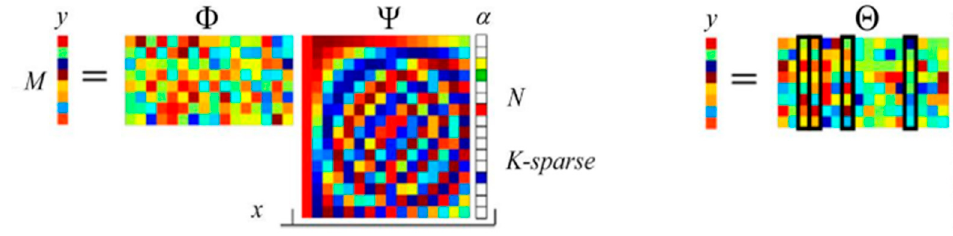
Figure 1. Linear measurement of CS [4].